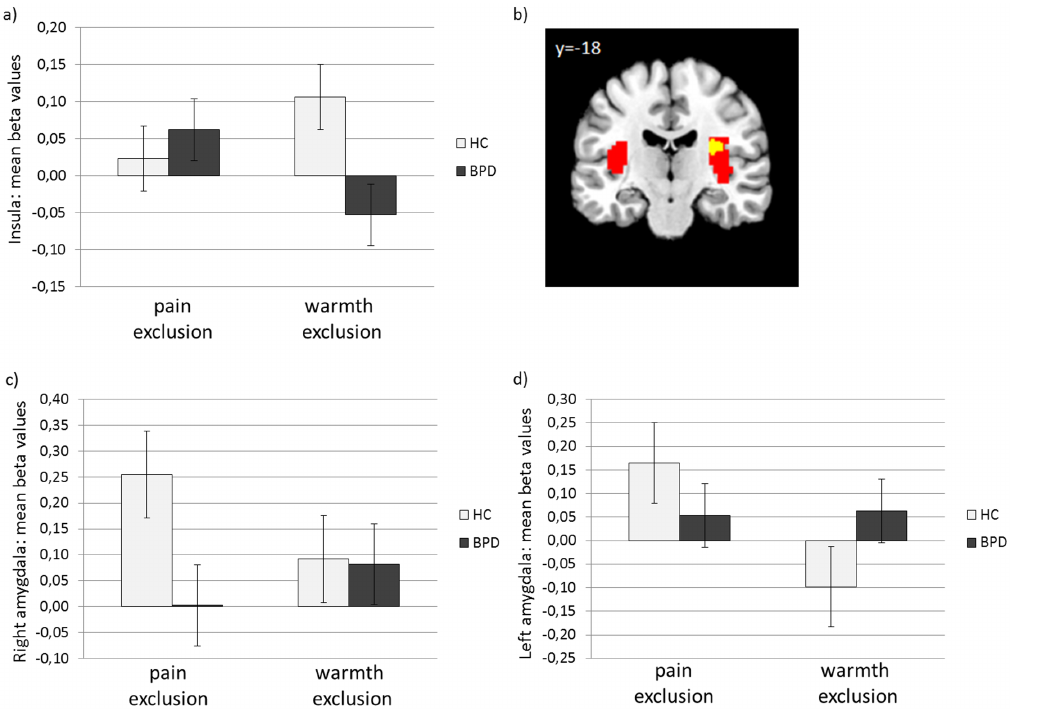
Fig 2. Insula and amygdala mean activation during painful compared to non-painful stimuli following social exclusion. a) mean beta values of peak voxel activation for HC and BPD in the insula, b) insula activation during pain after social exclusion independent of group (red), and the overlap of the general pain activation and the insula activation enhanced in BPD (yellow) (threshold for display: p < 0.005 uncorrected); mean beta values of peak voxel activation within c) the right amygdala, d) the left amygdala.